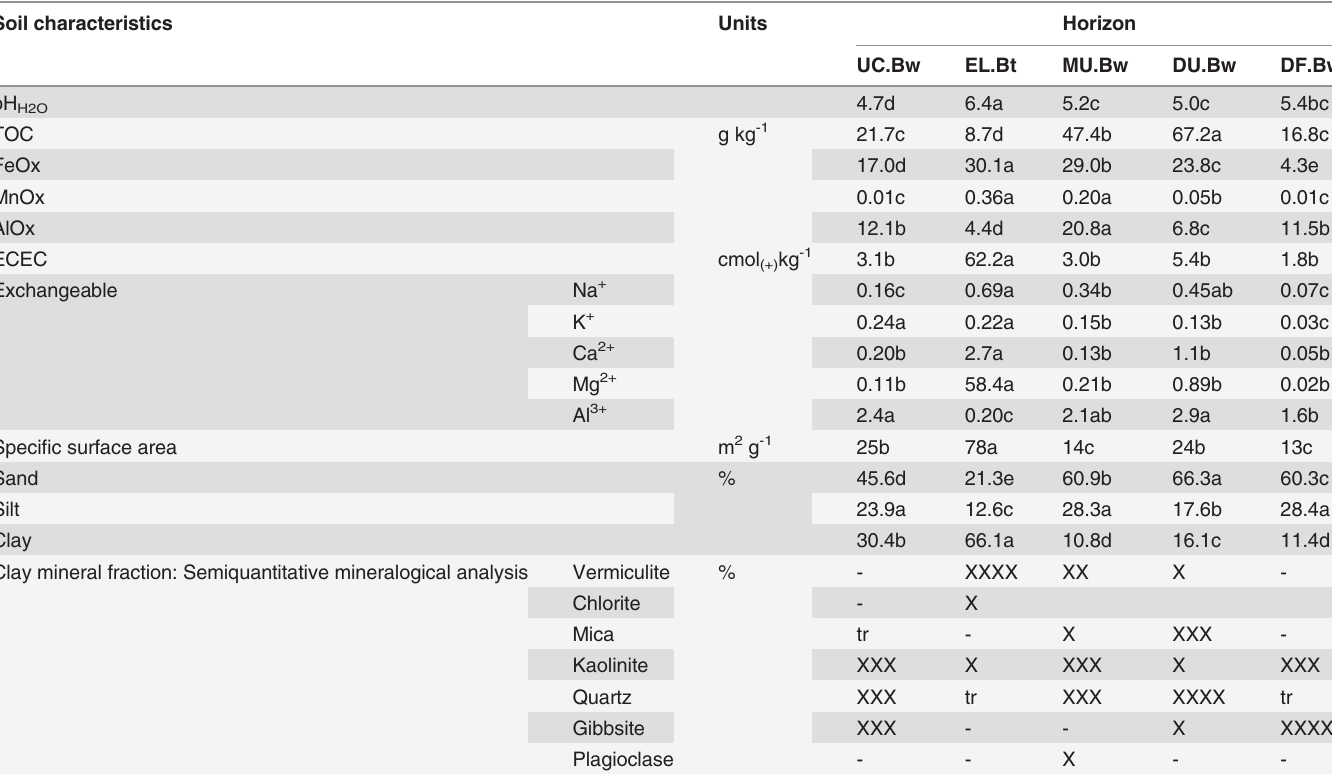
Table 1. Characteristics of soils.